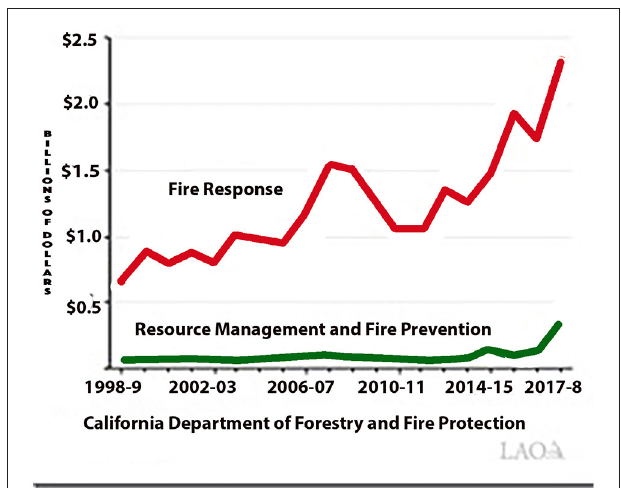
FIGURE 11 | Spending on fighting fire vs. preventing fire, CalFire (Legislative Analyst’s Office, 2018).